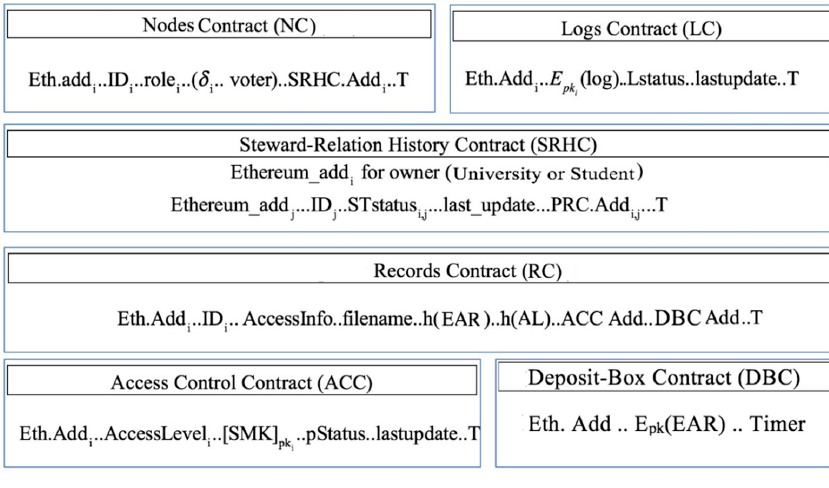
Figure 5. The proposed smart contracts.